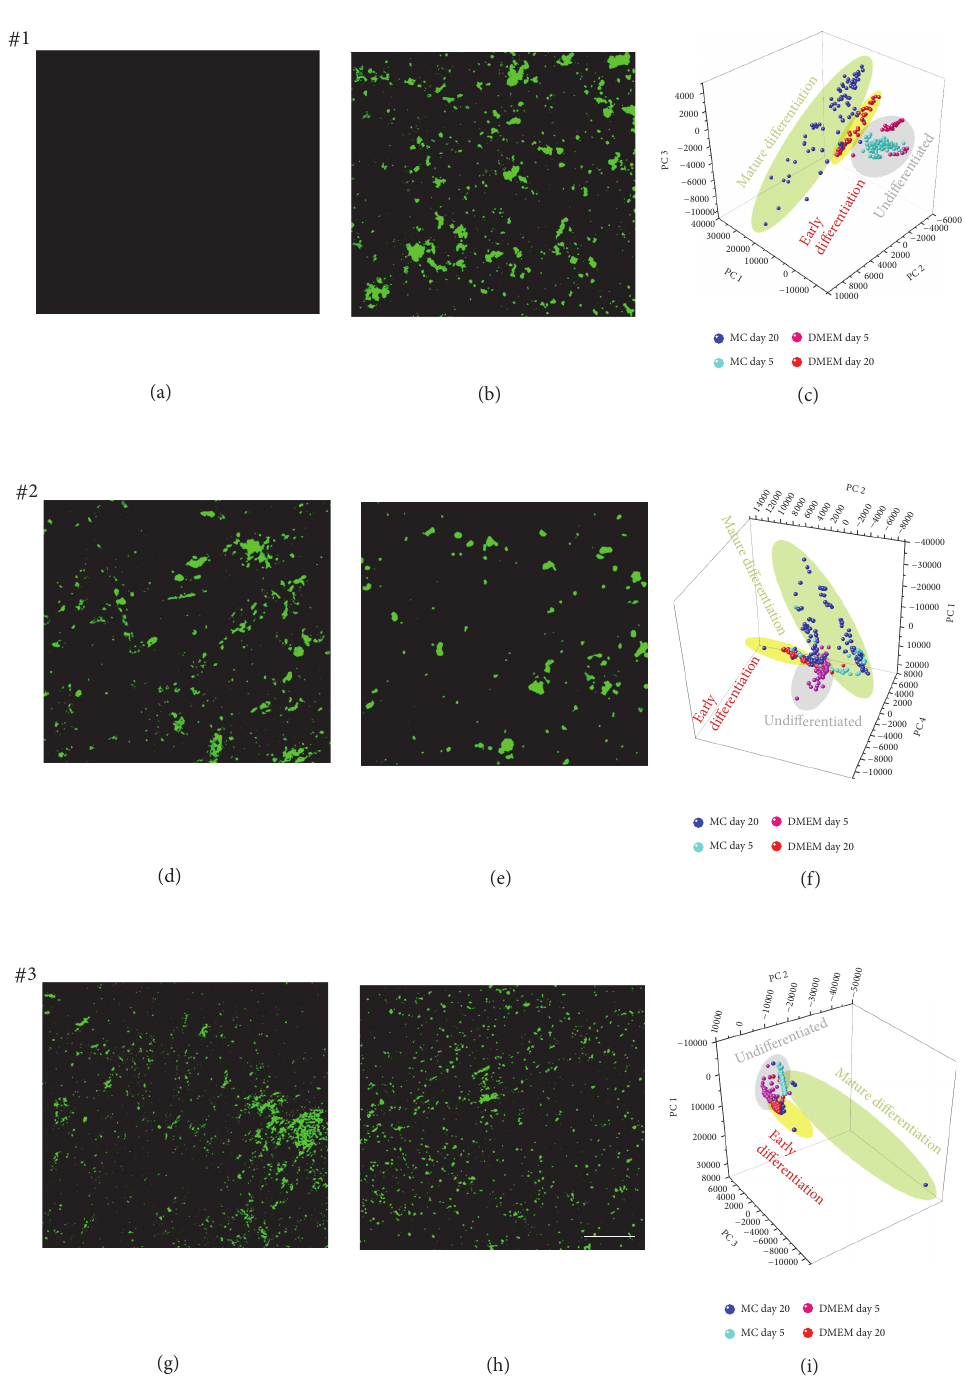
Figure 3: Fluorescence staining of hydroxyapatite and PCA of Raman spectra from differentiated MSCA-1 + JPCs. (a, b, d, e, g, h) OsteoImage fluorescence staining and (c, f, i) PCA scores plots of JPCs isolated from (a–c) patient #1, (d–f) patient #2, and (g–i) patient #3 after differentiation in (a, d, g) serum-containing DMEM and under (b, e, h) serum-free conditions (MC) for 20 days. Scale bar equals 200 𝜇 m. (c, f, i) PCA plots of Raman spectra using PCs shown in Figure 4. The PCAs reflect a more mature bone formation (green ellipse) under MC media conditions compared to DMEM conditions (yellow ellipse) after 20 days of differentiation for all